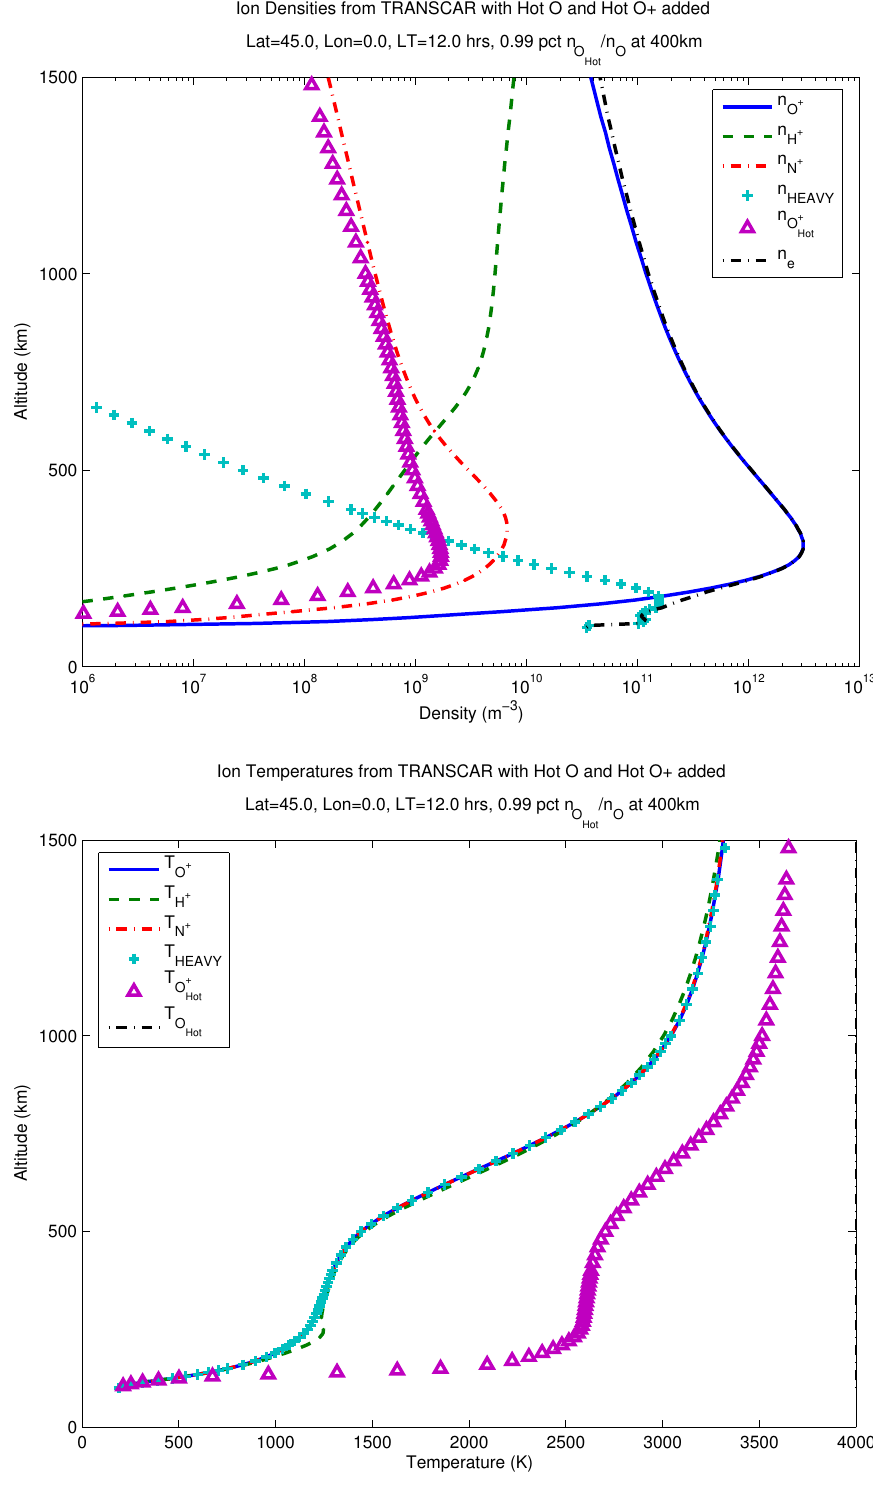
Fig. 7. Ion densities n s and temperatures T s as simulated in TRANSCAR. This simulation includes our self-consistently modeled population of hot O + , with thermalization losses included.